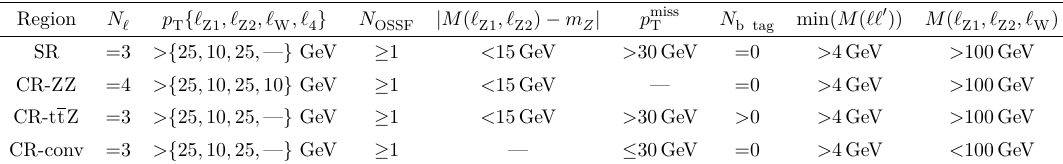
Table 1 . Requirements for the definition of the SR and the three different CRs designed to estimate the main background sources. The notation N to the number of opposite-sign same-flavour lepton pairs, and N tagged